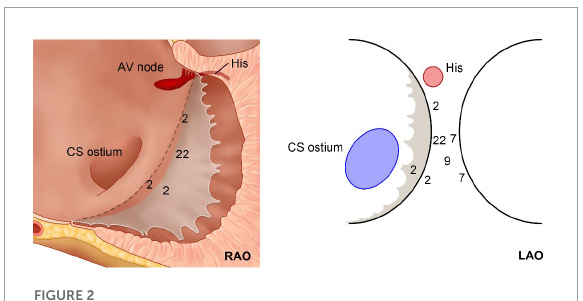
FIGURE2 Schematic diagram of the anatomical distribution of the 51 cases of